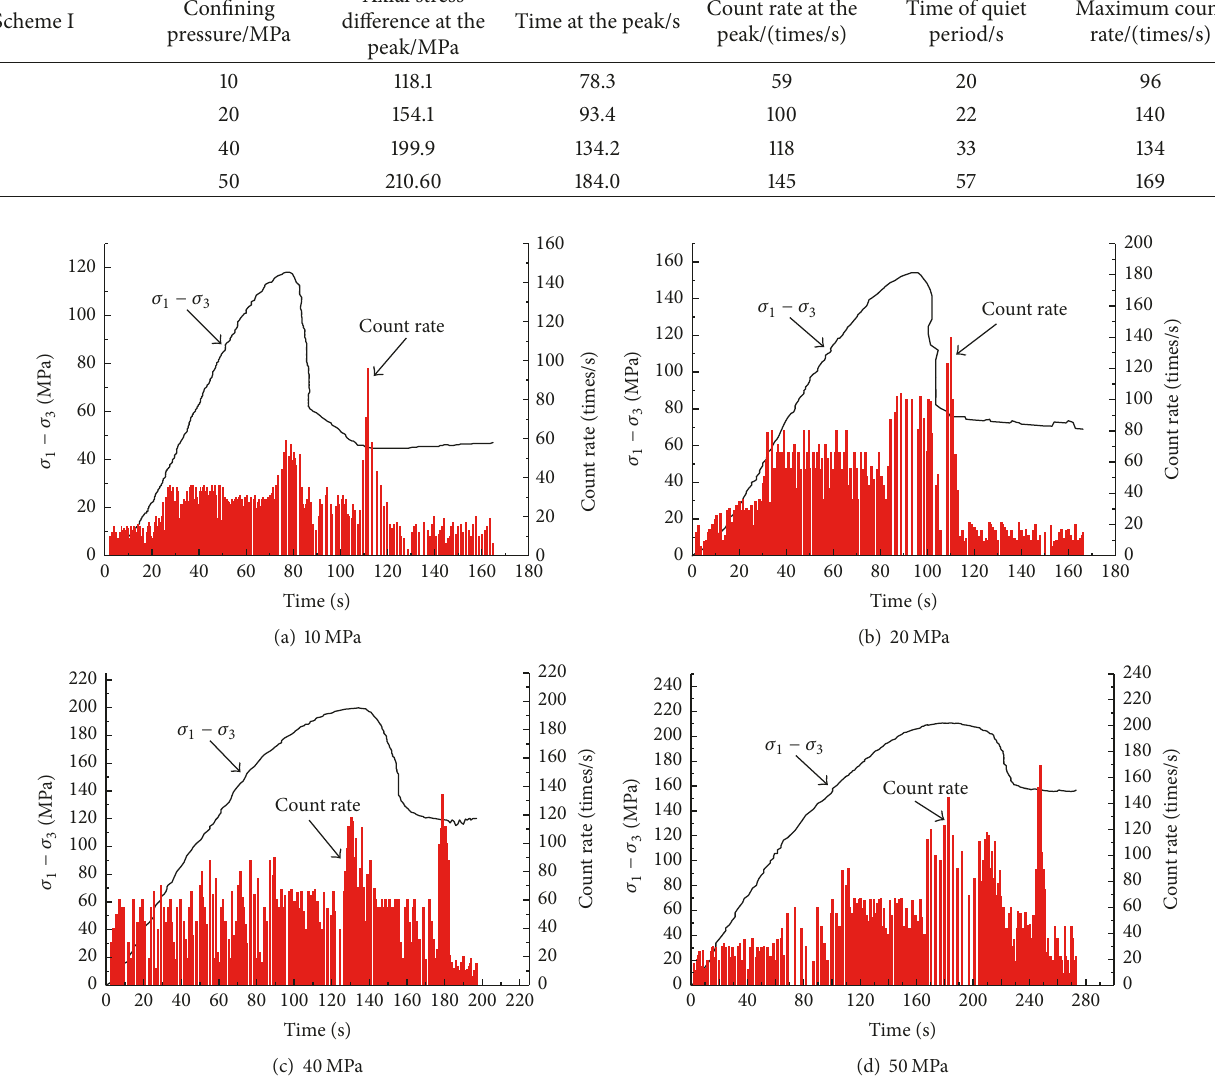
Figure 3: Curves of axial stress difference and count rate with time in sandstone failure process under various confining pressures in Scheme